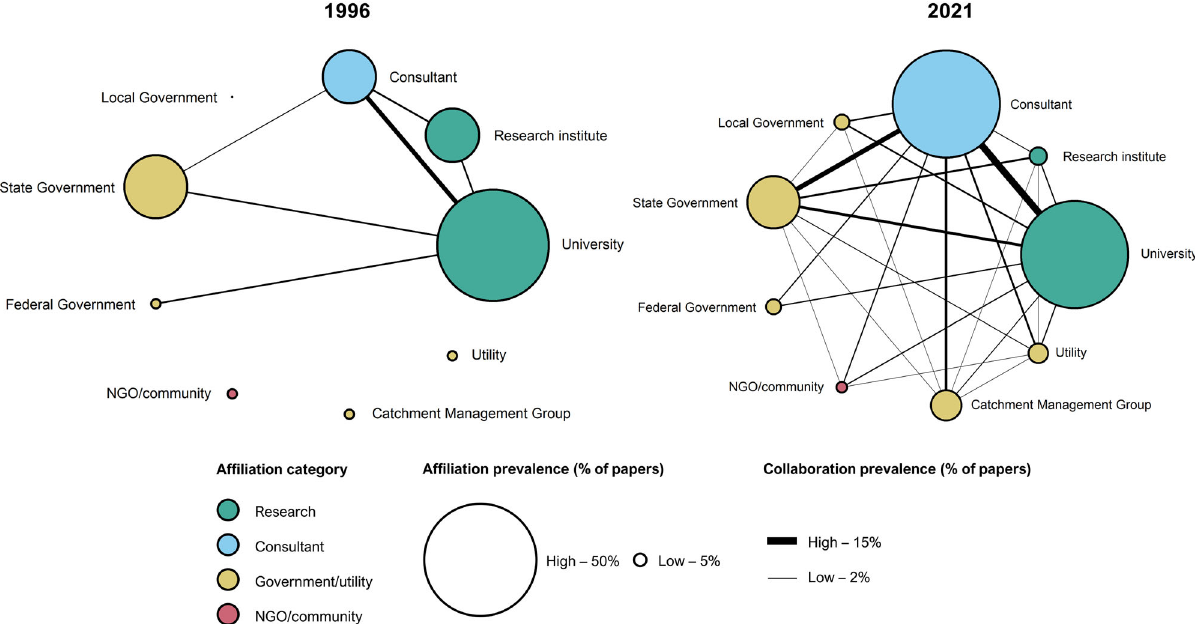
Fig. 3 Collaboration networks were broader and stronger in 2021 than 1996. Diameter of nodes indicates proportion of papers with each af fi liation type represented, while the width of the lines linking nodes indicates the proportion of papers with collaboration between af fi liation types. For example, a paper with authors from two institutions will have both institutions counted and one collaboration between them counted (therefore proportions do not sum to 100%). Nodes are coloured by af fi liation category (research in green, consultant in blue, government/utility in yellow, and NGO/community in